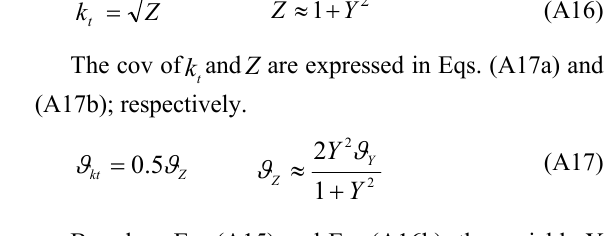
Table A5: Reliability Factor for Beam Strength Reliability Goal Normal Variate Reliability